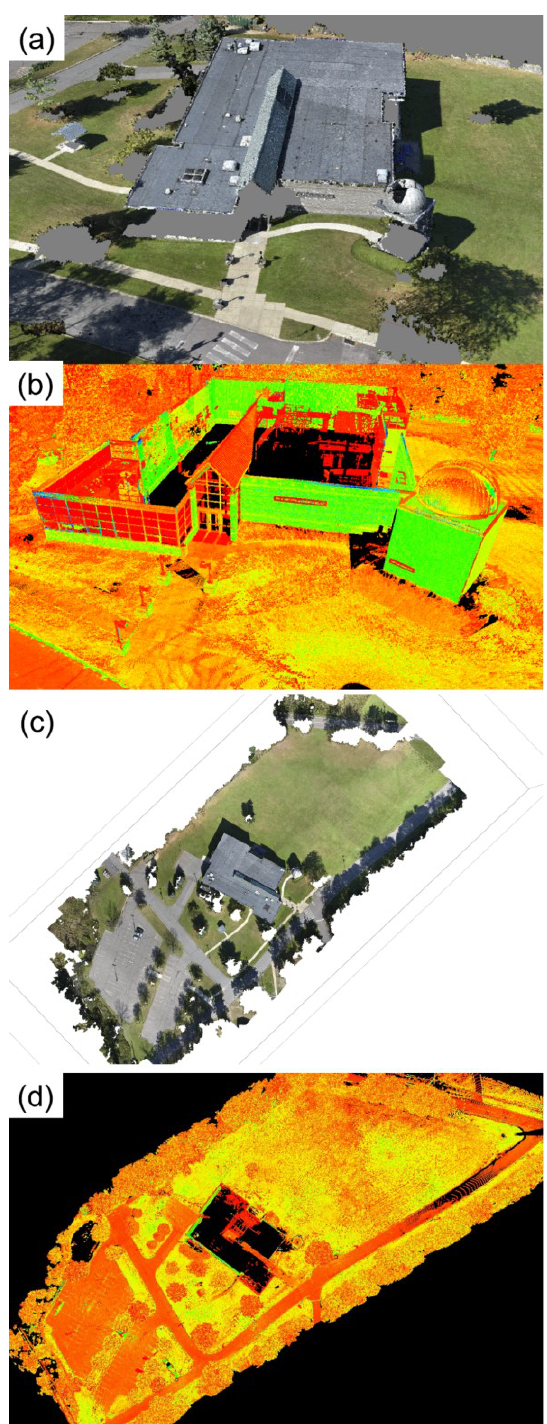
Figure 1. sUAS and TLS datasets. (a) sUAS point cloud, side view of the Bell Center for Technology building; (b) TLS point cloud, side view of the Bell Center for Technology building; (c) sUAS point cloud, top view of the study area; (d) TLS point cloud, top view of the study area. Colors in Figures (b) and (d) of the TLS point clouds correspond to laser scanner intensity